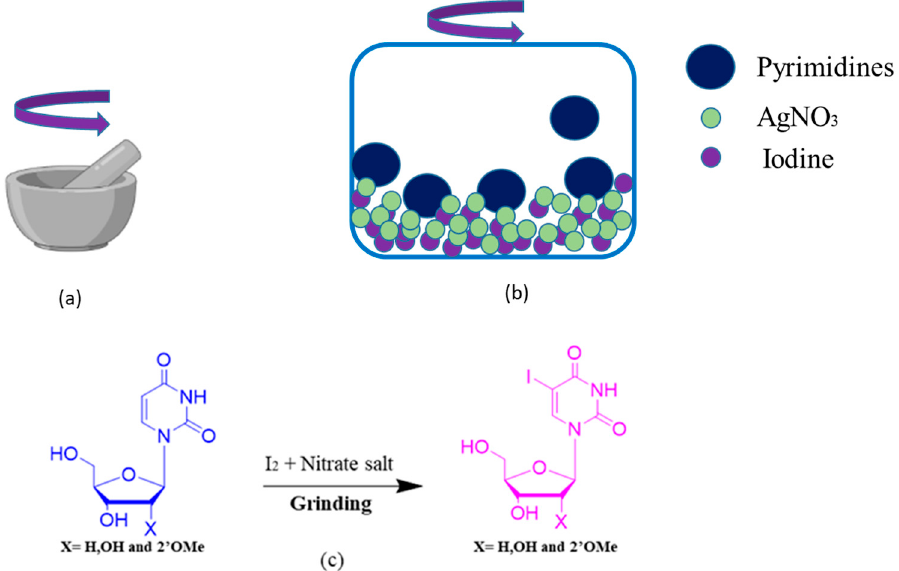
Figure 1. Schematic representations of the mechanical grinding reaction. ( a ) Grinding with a mortar and pestle (“grindstone” activation); ( b ) high-speed vibration milling in a mixer mill (activation of the compound); ( c ) C5 iodination of pyrimidine derivatives under solvent-free conditions.